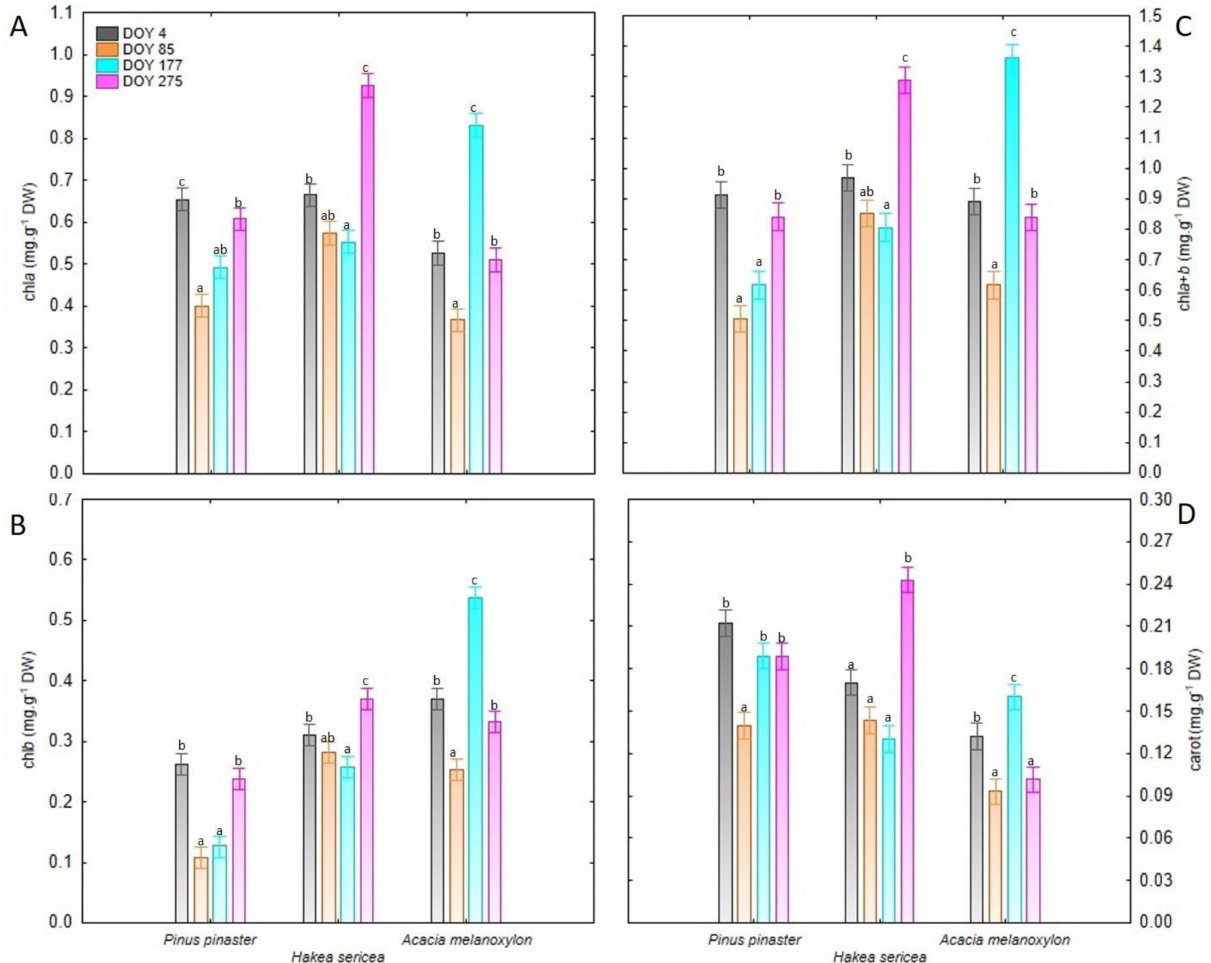
Figure 2. ( A ) Chlorophyll a (chl a ), ( B ) chlorophyll b (chl b ), ( C ) total chlorophyll (chl a + b ), and ( D ) carotenoid (carrot) contents in leaves of all analyzed species ( Pinus pinaster , Hakea sericea and Acacia melanoxylon ) on the four sampling dates. For each species, different lowercase letters indicate significant differences between day of the year (DOY) according to the Tukey’s HSD test results.